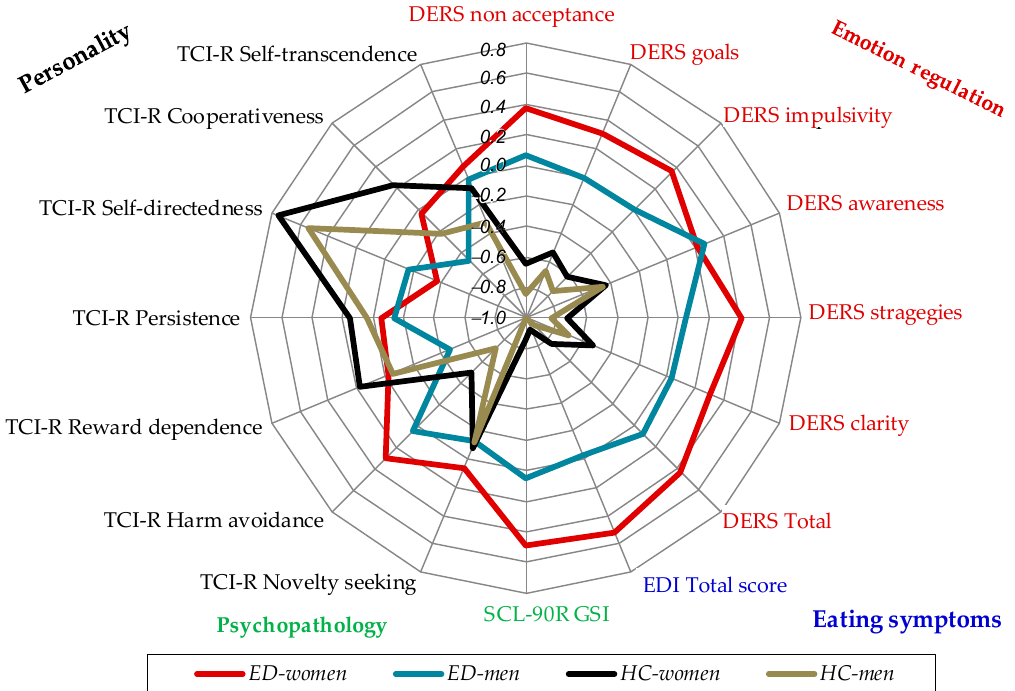
Figure 1. Radar-chart with the z-standardized means by group ( n = 1082). DERS: Difficulties in Emotion Regulation Scale; ED: Eating disorders; EDI-2: Eating Disorders Inventory-2; HC: Healthy controls; TCI-R, SCL-90R: Symptom Checklist-90 Items-Revised; Temperament and Character Inventory revised.